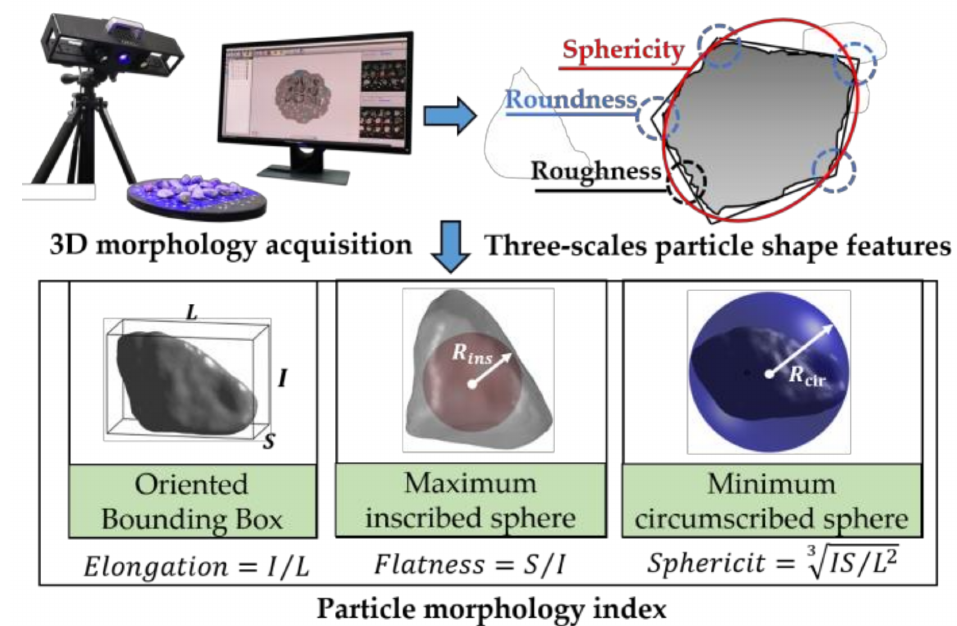
Figure 2. Illustration of the shape quantification of coarse particles recycled from